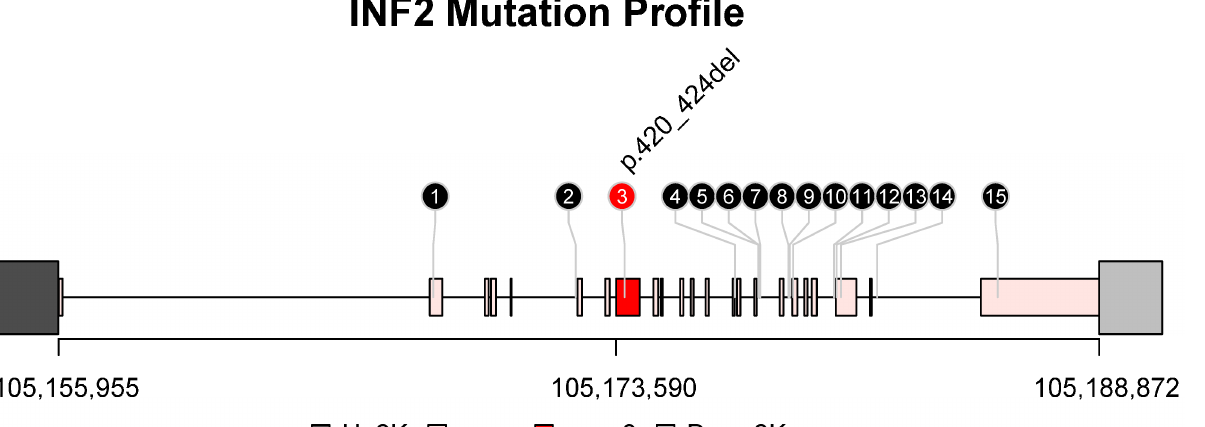
Figure 5. Lolliplot illustrating the mutation profile in INF2 based on the whole exosome sequencing results of the patients. Note: All SNPs and INDELs in INF2 were plotted. The numbers inside the circle represented the mutation order. The start and end positions were indicated on the horizontal axis. All exons were filled in mistyrose. The upstream and downstream 2K regions were coloured with dark grey and light grey, respectively. Harmful mutations were represented with red circles, while harmless mutations were represented with black circles.